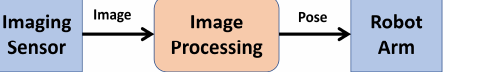
Figure 1. Intelligent robotic grasping system based on computer vision.